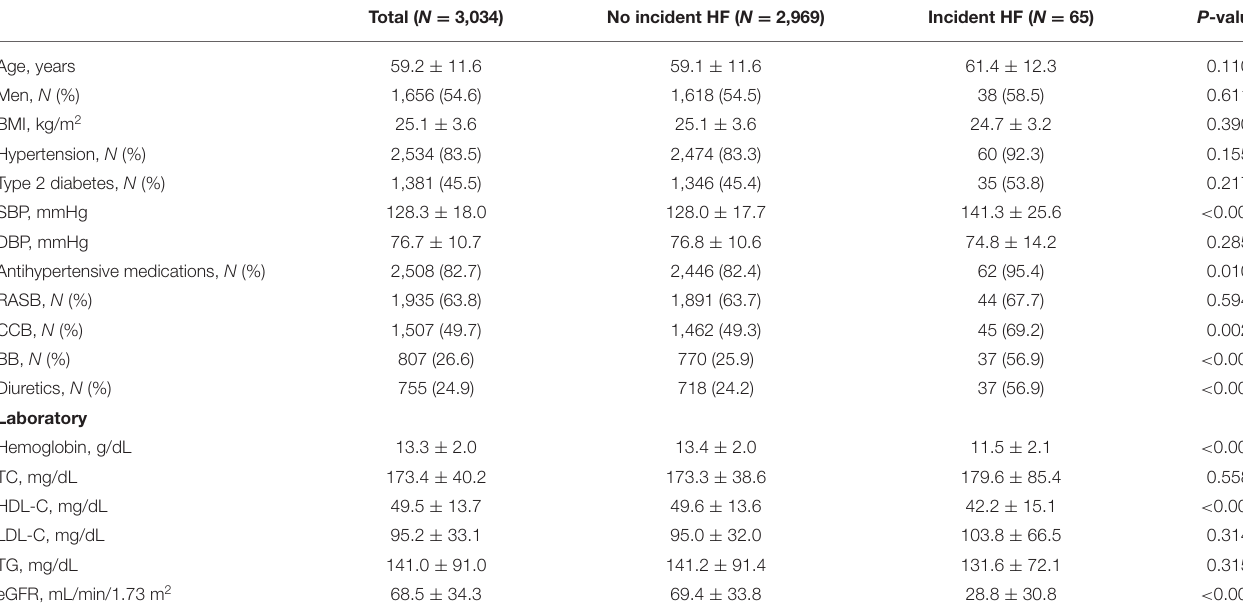
TABLE 1 | The clinical characteristics of study participants according to incident heart